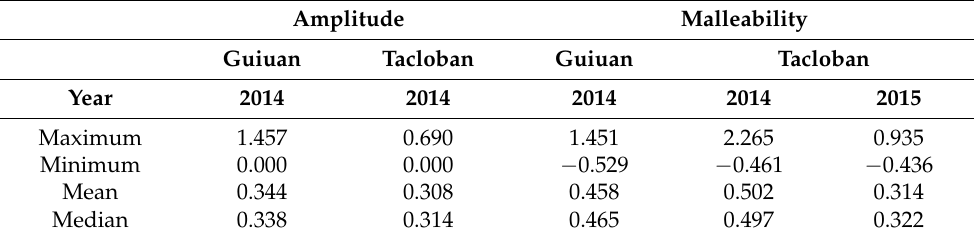
Table 2. Statistical summary of pixel-wise amplitude and malleability.